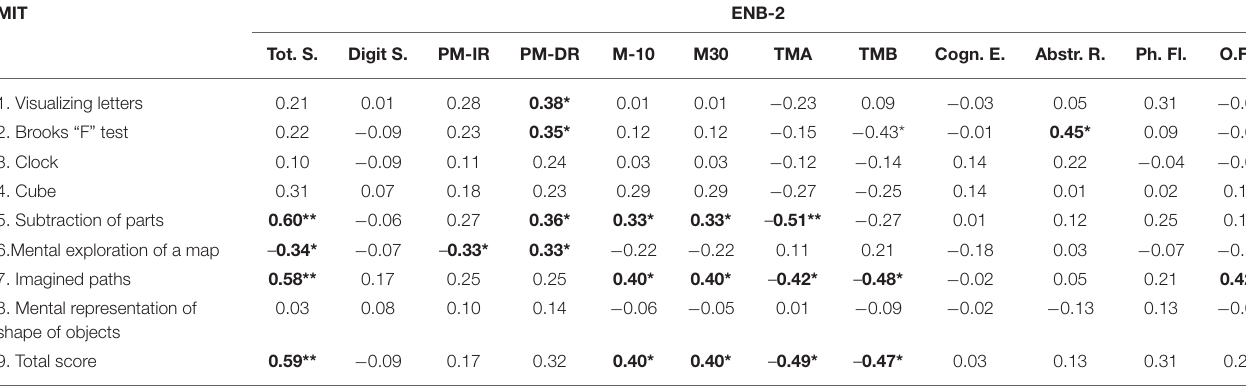
TABLE 5 | Correlations among MIT subscales and ENB-2